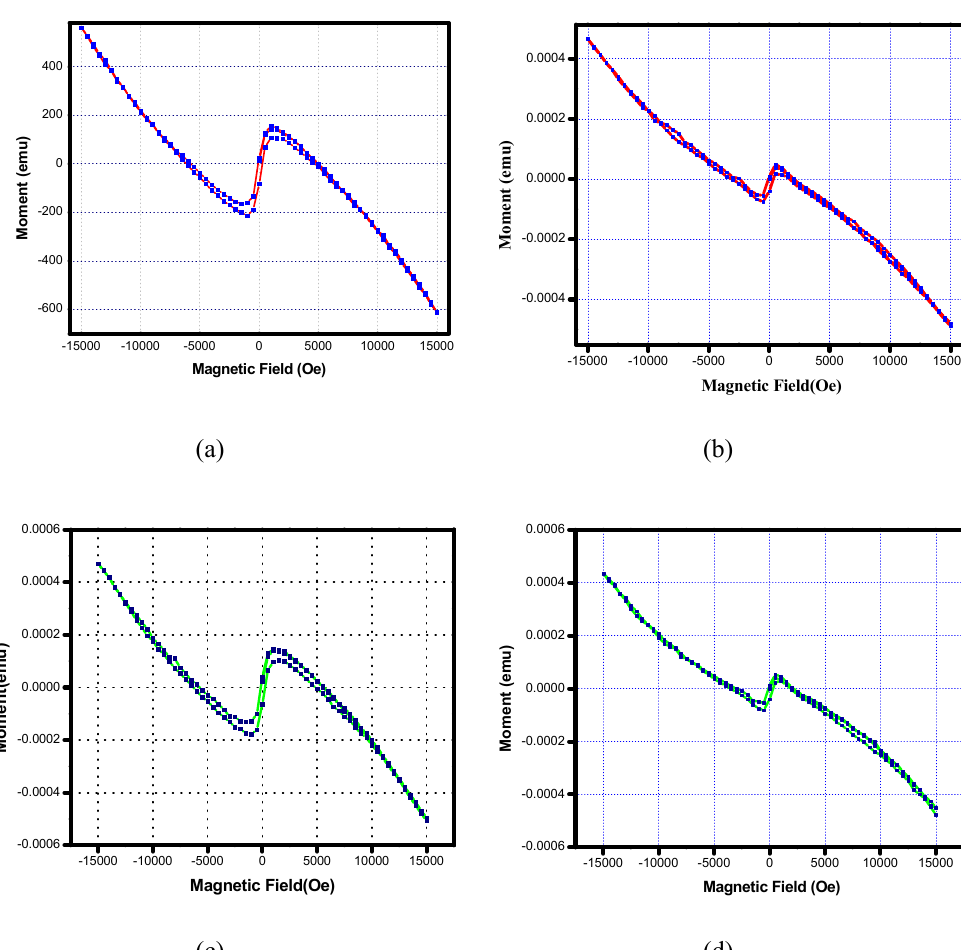
Fig. 7. M-H loops of (a) pure (b) Cu-1 (c) Cu-2 and (d) Cu-3 ZrO